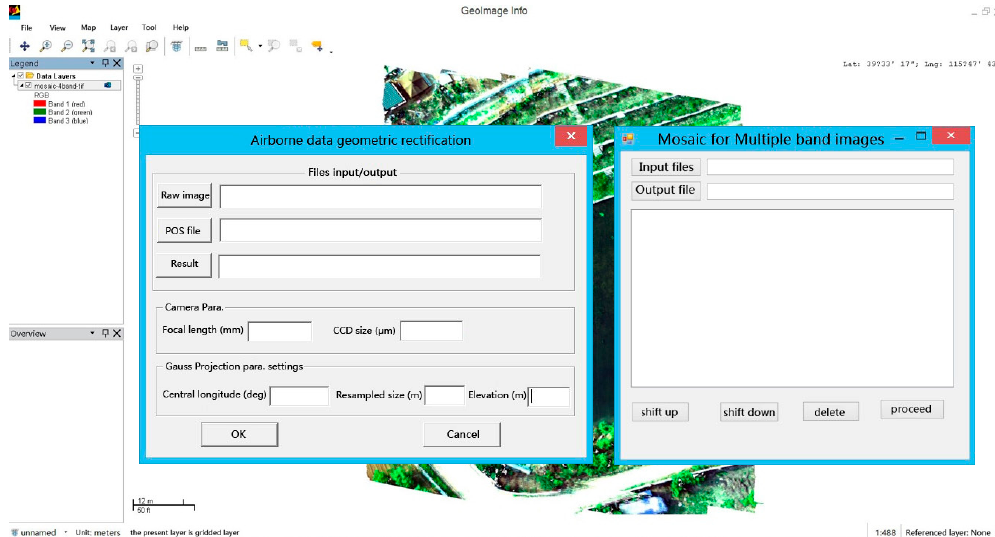
Figure 5. Main interface of processing software.